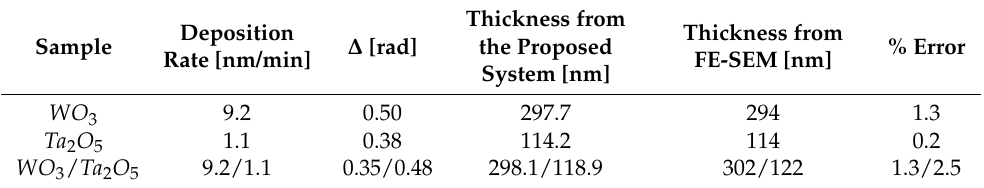
Figure 7. Cross-sections of WO 3 , Ta 2 O 5 and WO 3 / Ta 2 O 5 films taken by FE-SEM. Table 3. Summary of the thin film analysis and comparison results between the proposed system and FE-SEM.